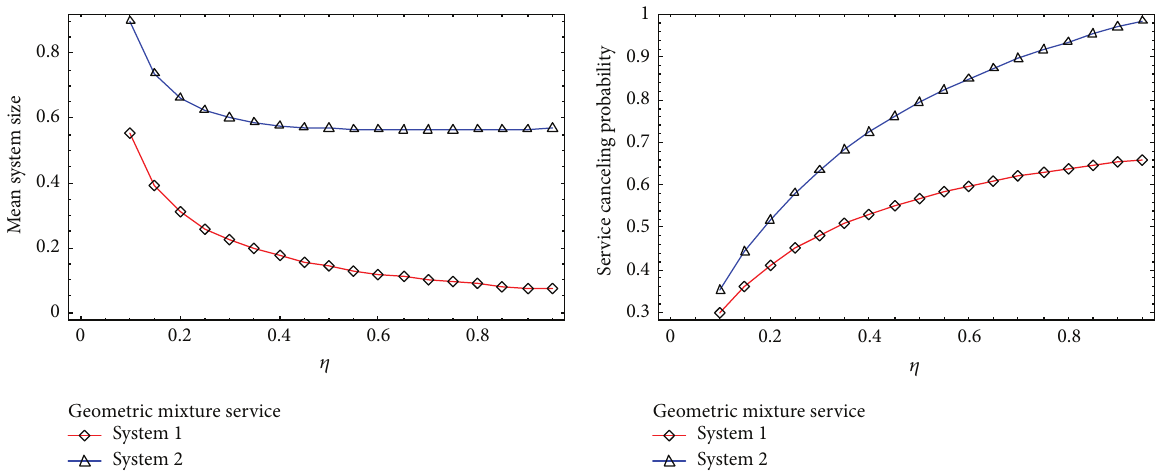
Figure 3: Mean system size and service canceling probability over 𝜂 with geometric mixture service time